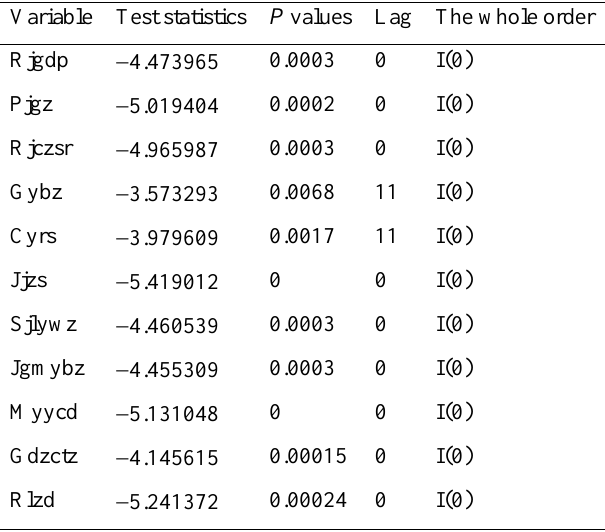
Table 2 Analysis of test results based on ADF unit